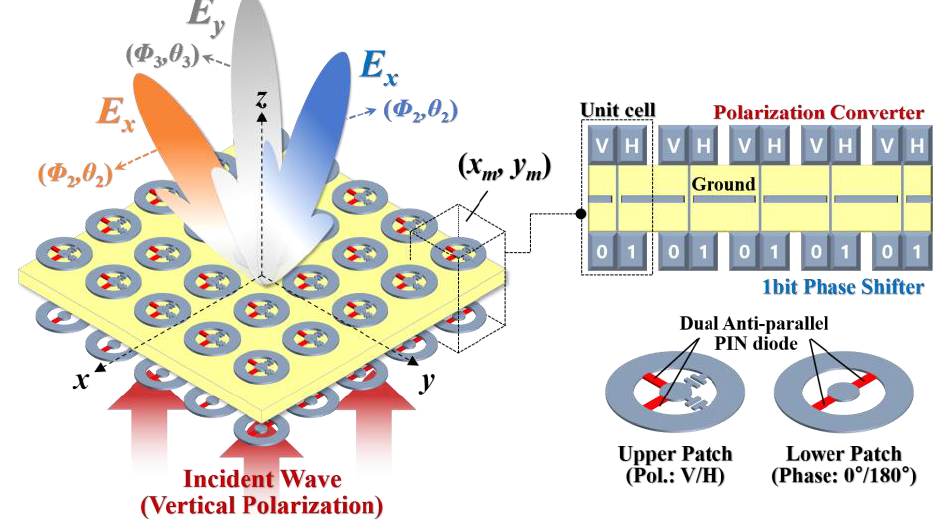
Figure 1. Conceptual schematic view of the proposed multi-functional transmitarray.